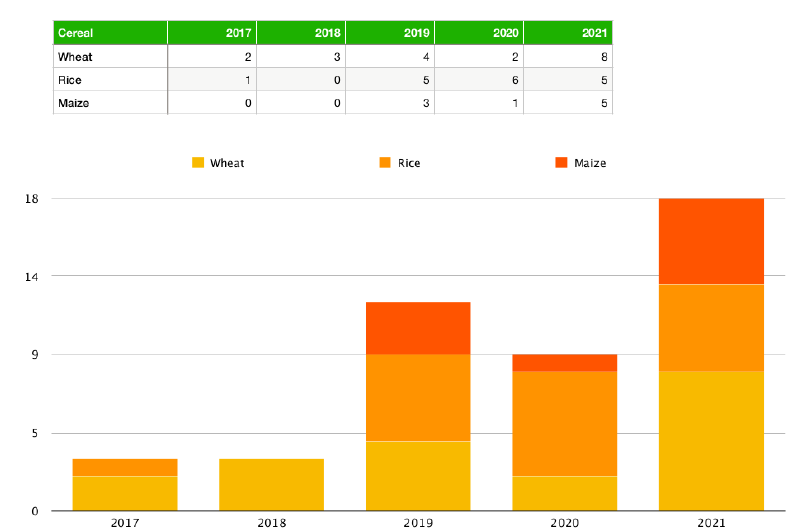
Figure 4. Distribution of research papers by year.